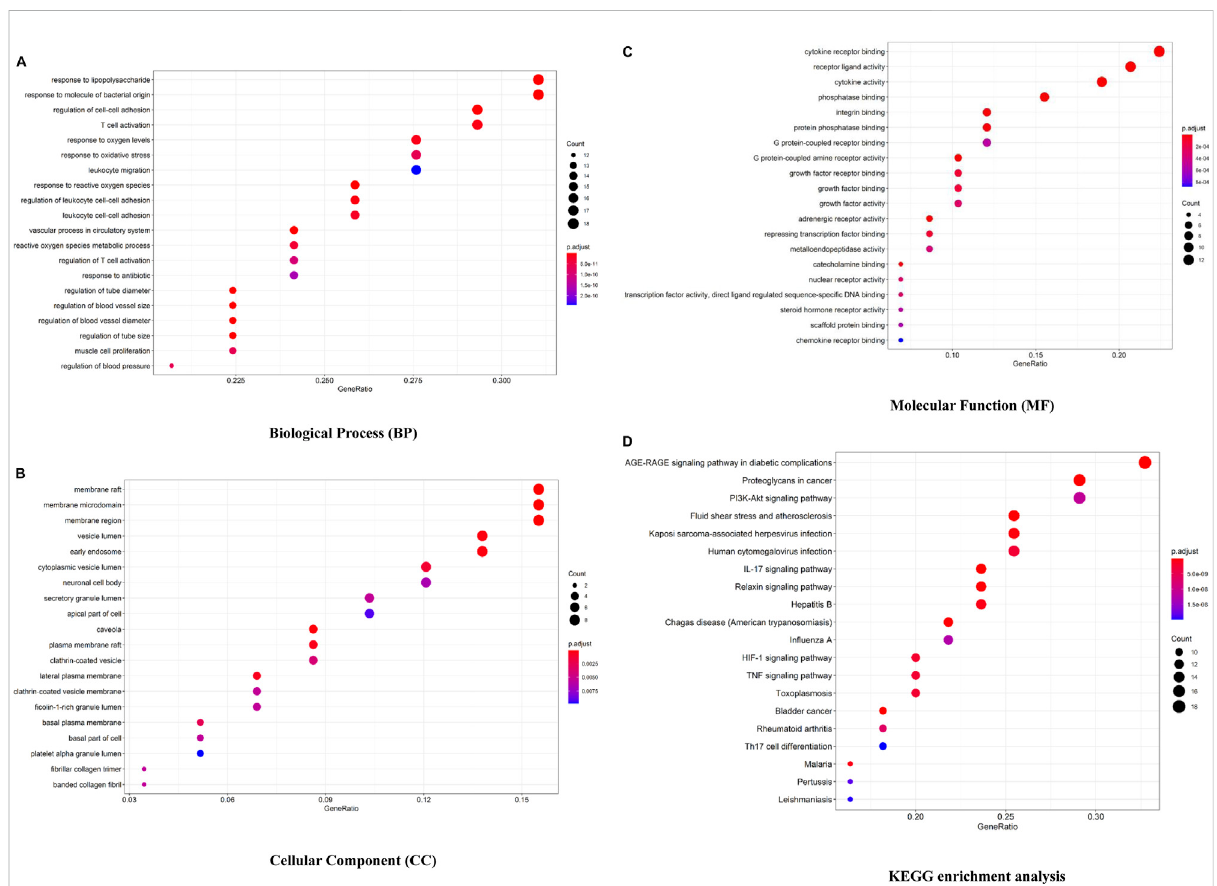
FIGURE 3 Bioconductor database-enriched pathways and GO entries. (A) . GO enrichment entries in the top 20 about the biological process (BP). (B) . GO enrichment entries in the top 20 about cellular component (CC). (C) . GO enrichment entries in the top 20 about molecular function (MF). (D) . KEGG enrichment entries in the top 20 ( p < 0.05). The color of the bubble represents the value of p, and the size of the bubble represents the count of relative